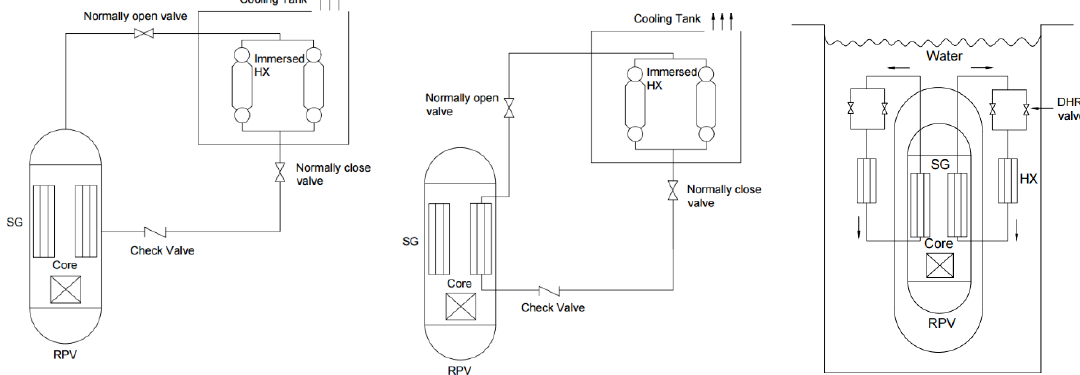
Figure 2. Passive residual heat removal system (PRHRS) coupled with reactor pressure vessel (RPV) and coupled with steam generators (SGs) (heat exchangers (HXs) immersed in cooling tank and reactor pool) .